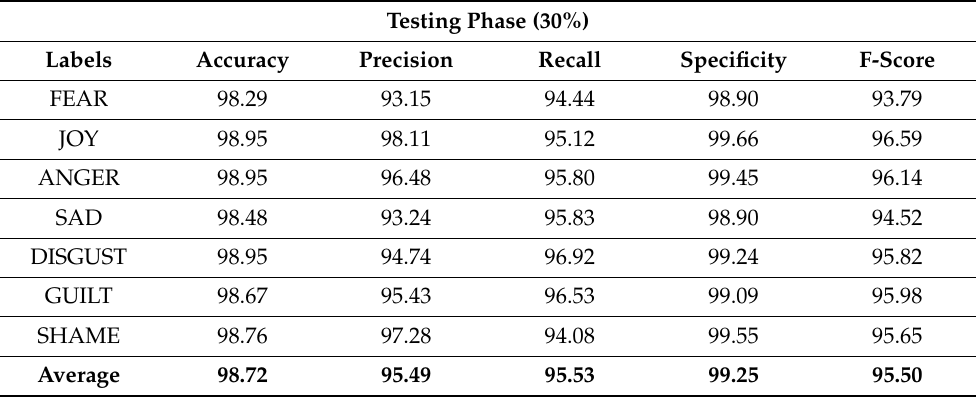
Table 4. Result analysis of CLBEDC-SND approach with distinct class labels under 30% of TS data.